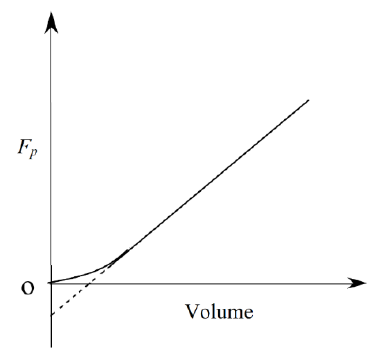
Fig. 7. The real relationship of particle buoyancy with its